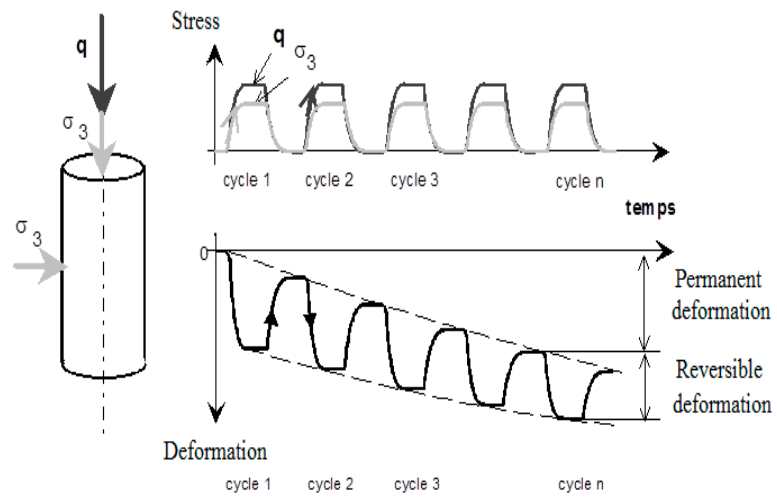
Figure 10. The principle of RLTT.